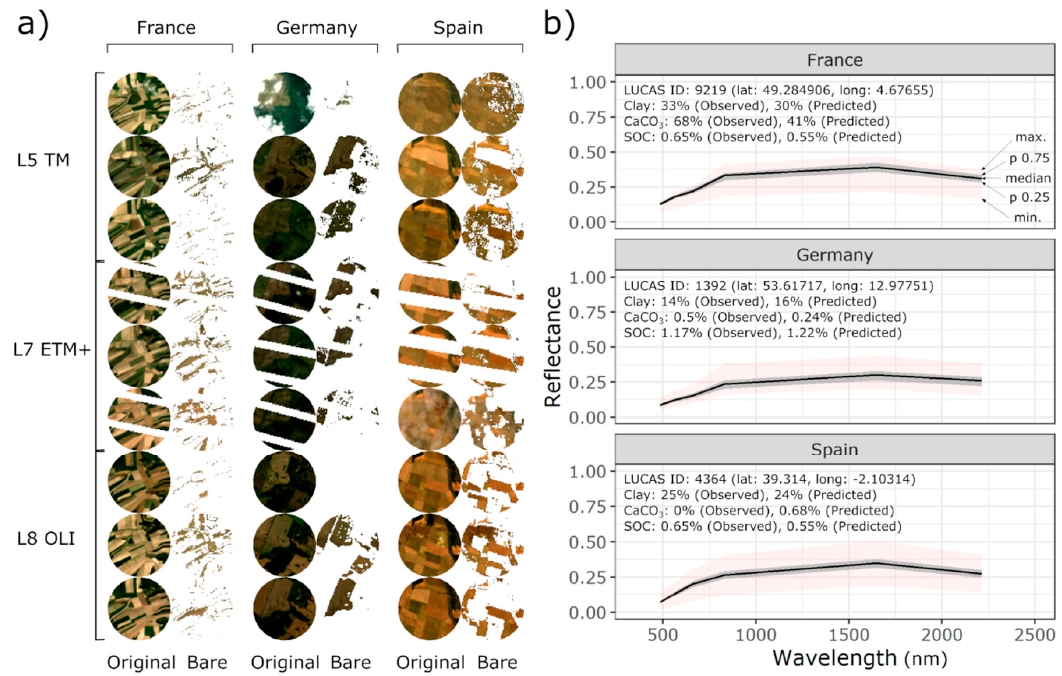
Figure 2. ( a ) Example of original scenes (true color composition) and bare soil masks from the Landsat collection (left panels), in this case considering the Landsat 5 Thematic Mapper (TM), Landsat 7 Enhanced Thematic Mapper Plus (ETM + ) and Landsat 8 Operational Land Imager (OLI), centered at the three LUCAS sampling points and with a circle buffer of 1000 m; ( b ) Dispersion of the full SYSI reflectance for the same sites, where the minimum, 0.25 percentile, median, 0.75 percentile and maximum values are provided. Full SYSI reflectance is defined by the median estimate, attenuating the influence of extreme values. Soil site characteristics are provided together with the spectral patterns.